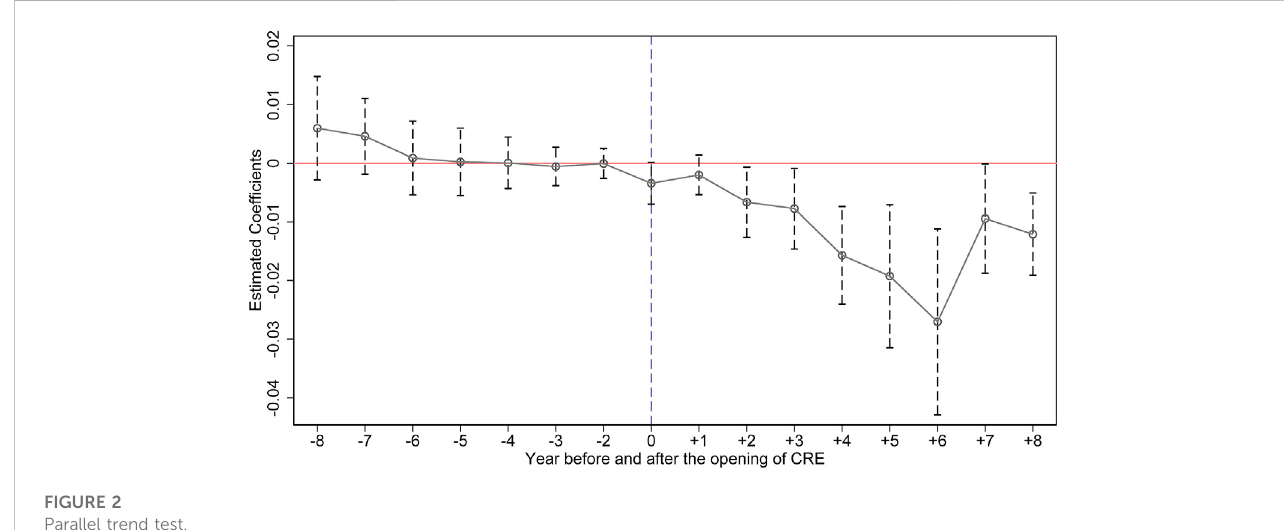
FIGURE 2 Parallel trend